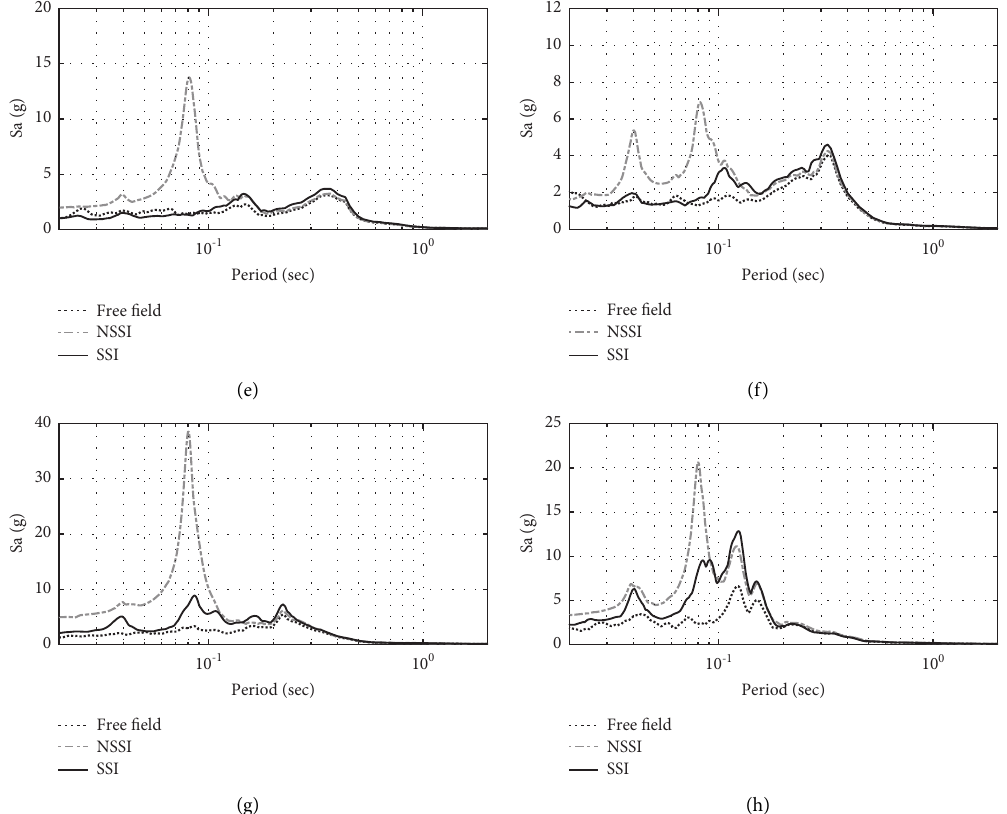
Figure 7: Comparison of ARS at the top of the 1 st floor for different soil conditions in each direction. (a) FI-EW. (b) AS-EW. (c) WS-EW. (d) WR-EW. (e) FI-NS. (f) AS-NS. (g) WS-NS. (h)